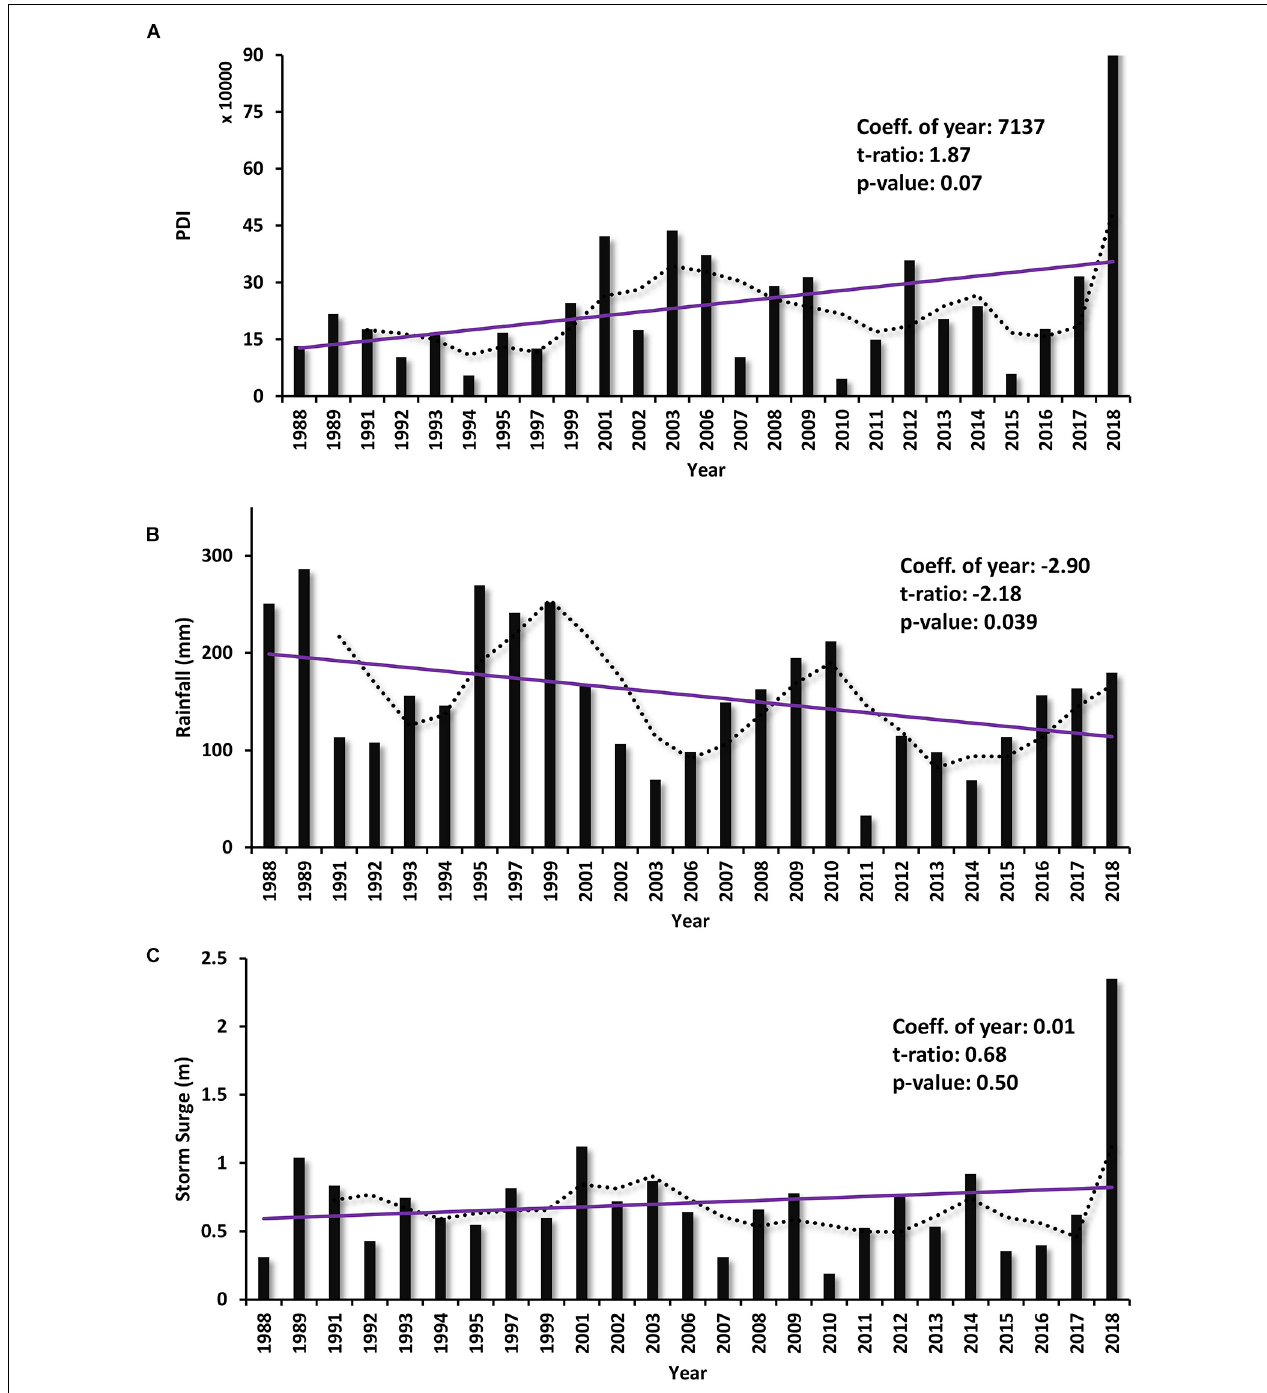
FIGURE 4 | Time series of different TC-induced hazards (A) PDI, (B) rainfall, and (C) storm surge associated with TCs affecting Hong Kong. The solid purple lines show the long-term trend (correlation between the series and time) at a confidence interval of 95% ( p = 0.05) and the dotted black lines are the 5-year moving